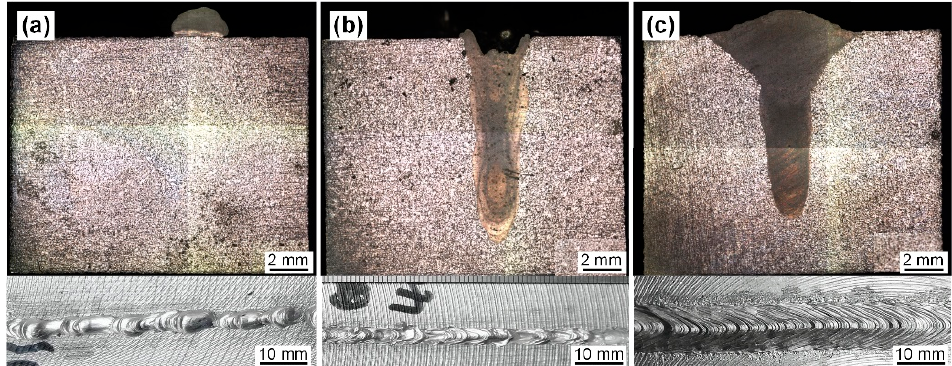
Figure 4. Macro morphologies; ( a ) arc welding, ( b ) laser welding and ( c ) laser-arc hybrid welding for weld #3.